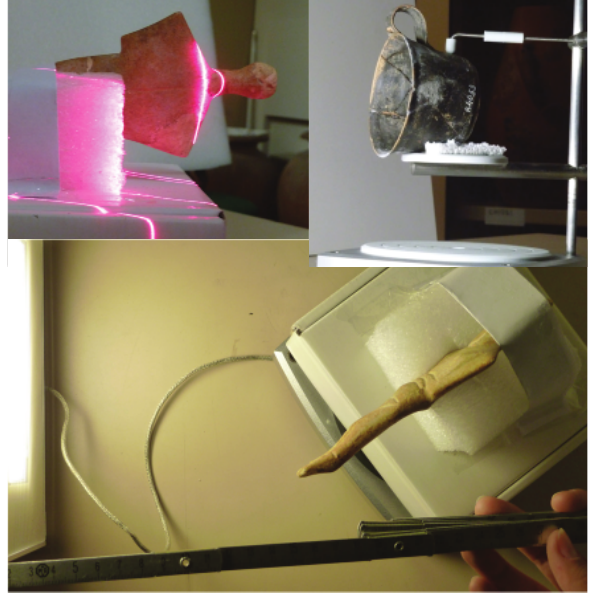
Figure 5. Above, photographic documentation of artifacts positioning; below, checking range